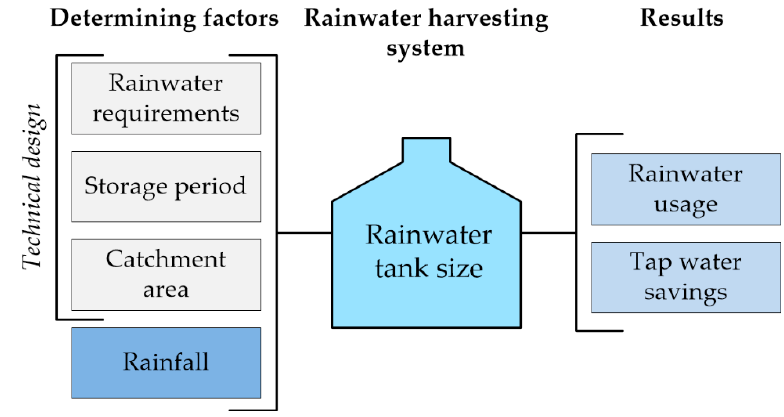
Figure 2. A schematic framework of a residential rainwater harvesting system (RWH) inputs and outputs.